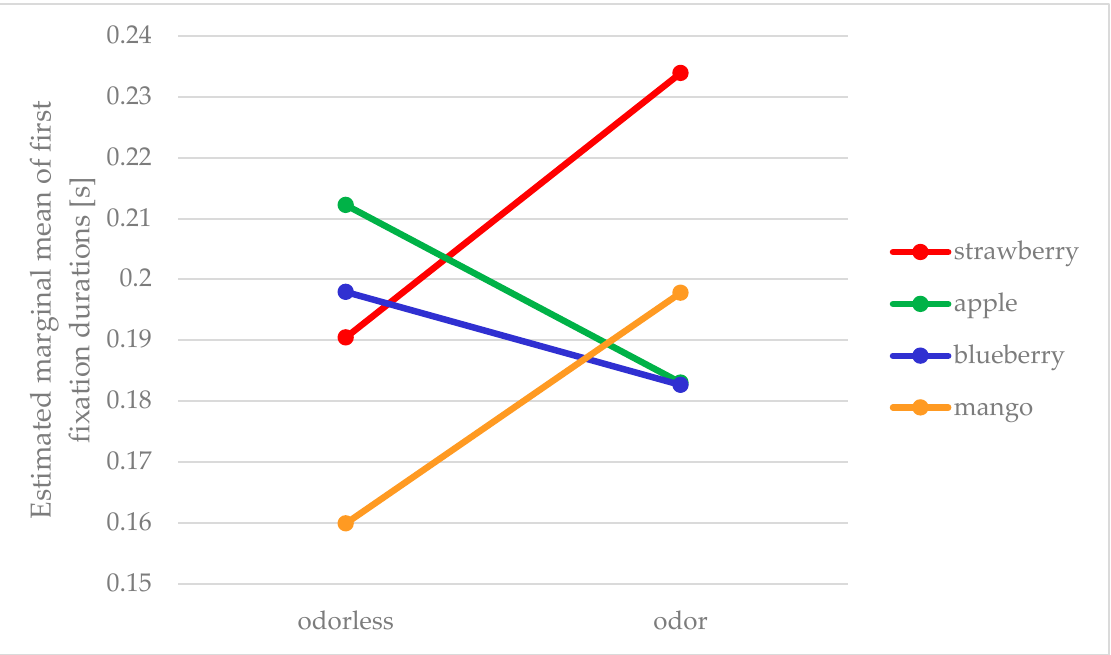
Figure 4. First fixation durations between the odor and odorless conditions for the yoghurt product group.